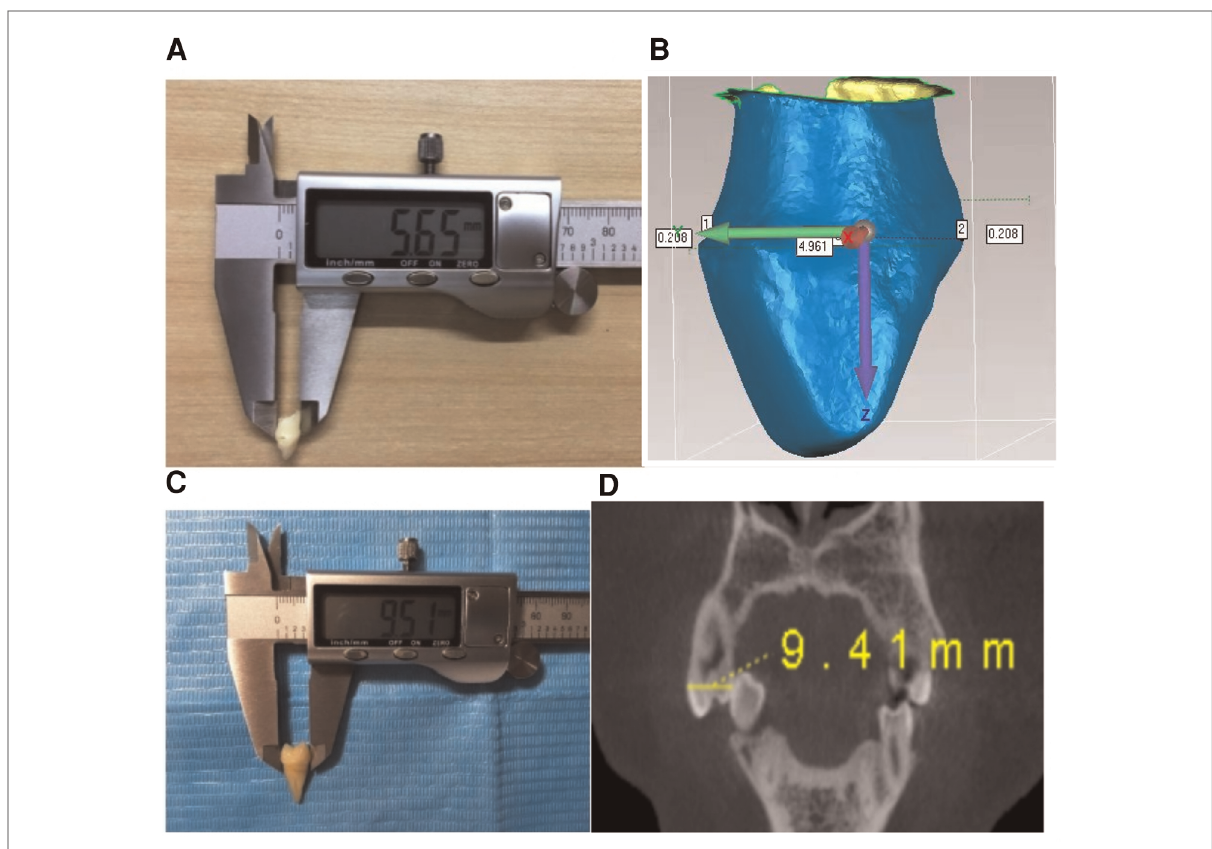
FIGURE 1 ( A ) Manual measurement of extracted primary teeth with a Vernier calliper. ( B) Digital measurement of extracted primary teeth with an intraoral scanner. ( C ) Manual measurement of extracted maxillary fi rst premolar with a Vernier calliper. ( D ) CBCT image digital measurement of maxillary fi rst